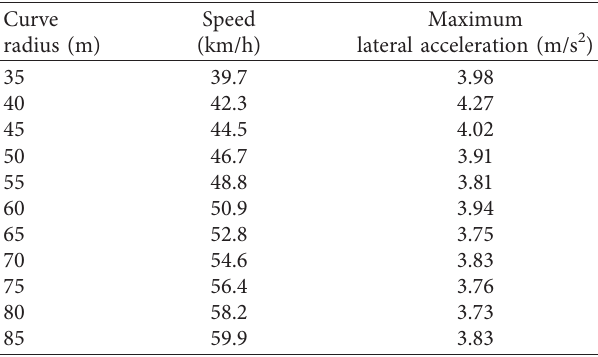
Table 2: The rollover thresholds at each curve radius.